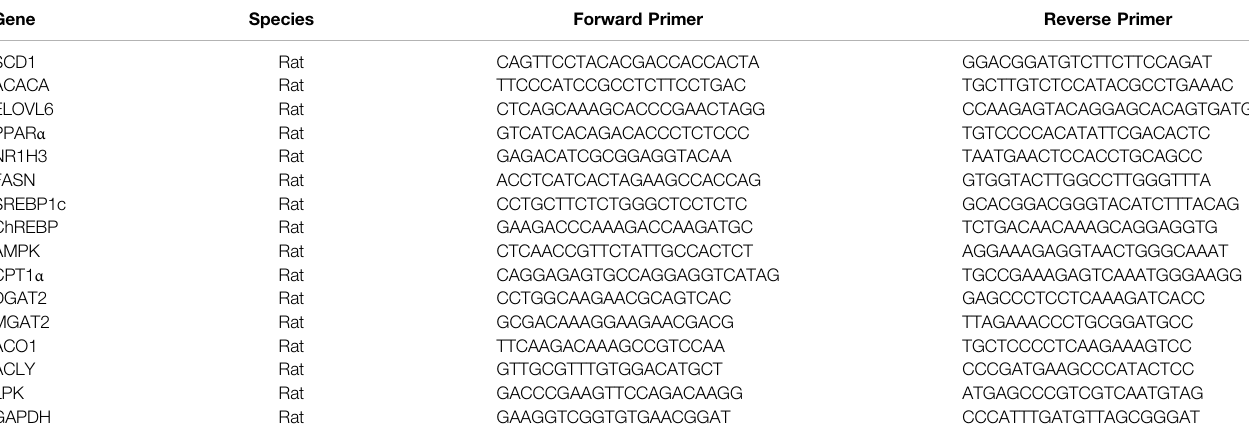
TABLE 1 | primers for